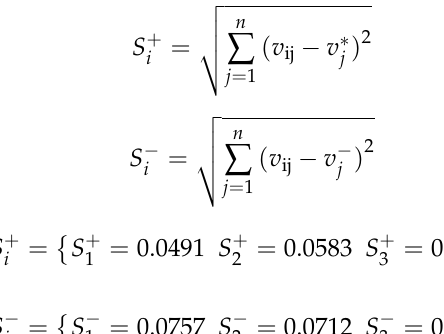
6. Calculate the relative closeness of solutions of each group to the ideal solution accord- ing to the following Equation (34):